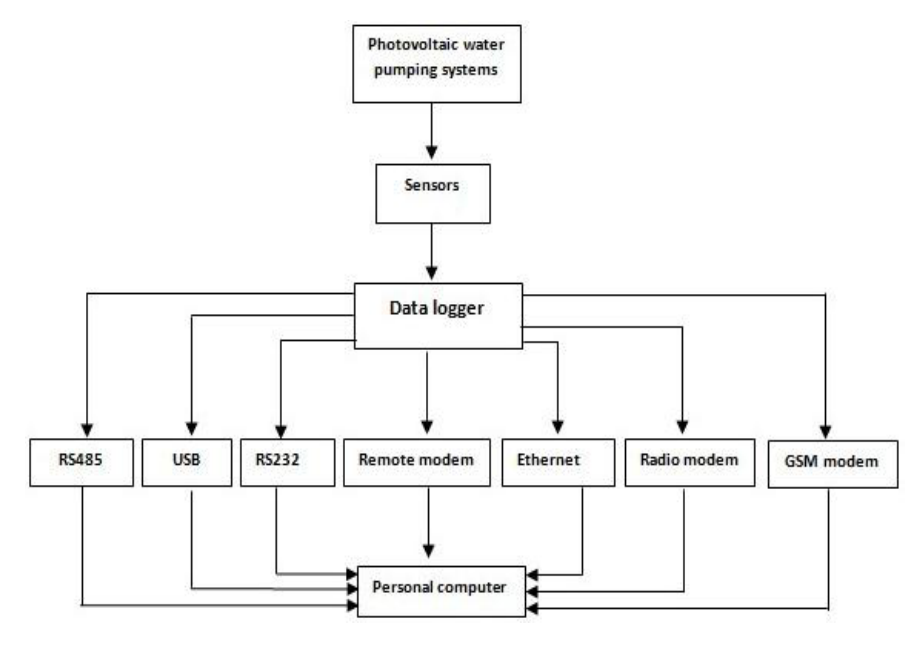
Figure 2. Field data transmission possibilities.